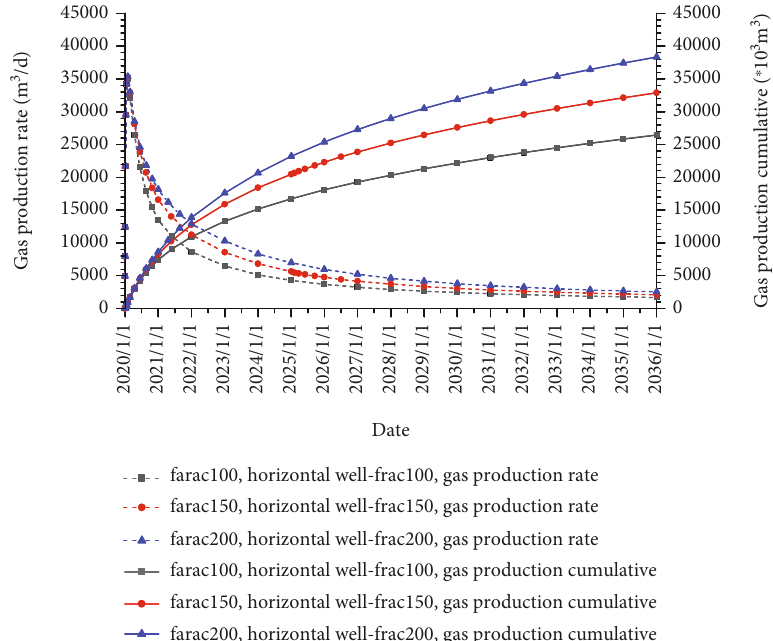
Figure 9: Cumulative gas production per well at di ff erent fracture lengths.